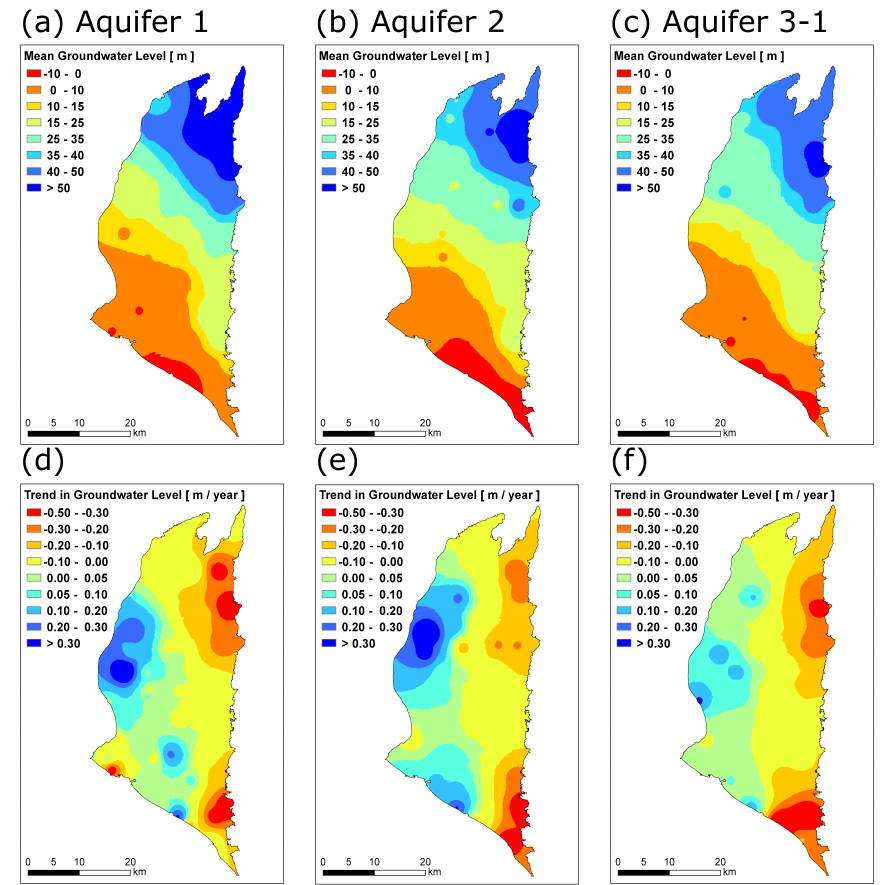
Figure 5. The ( top ) panel shows the spatial distribution of mean groundwater levels in Aquifers 1, 2, and 3-1, and the ( bottom ) shows the estimated trends in the corresponding aquifers over the PAP. We further investigated the variations in GLs before and after the identified change